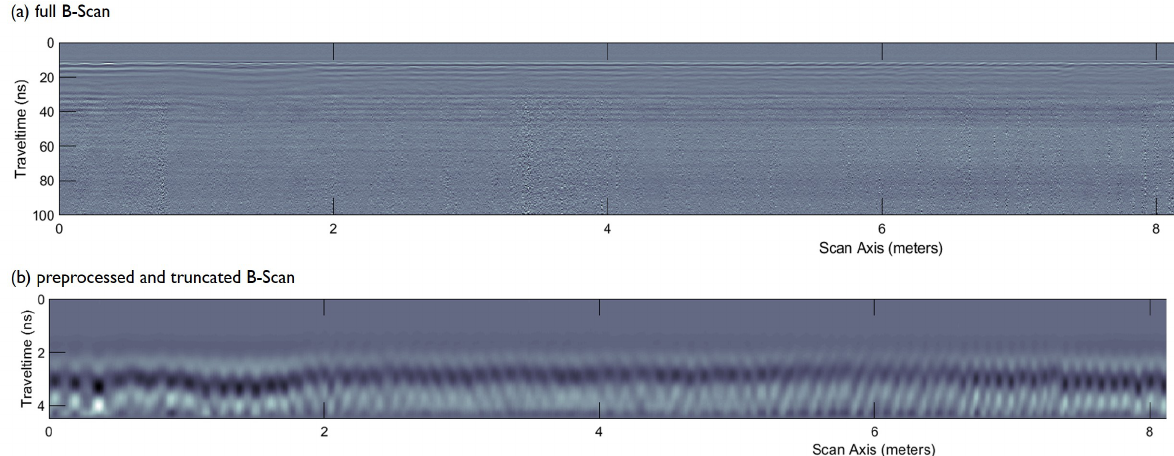
Figure 8. ( a ) Raw B-scan along the deck of the bridge collected with 900 MHz antenna and ( b ) preprocessed B-scan truncated to remove all internal reflections except the upper rebar layer.